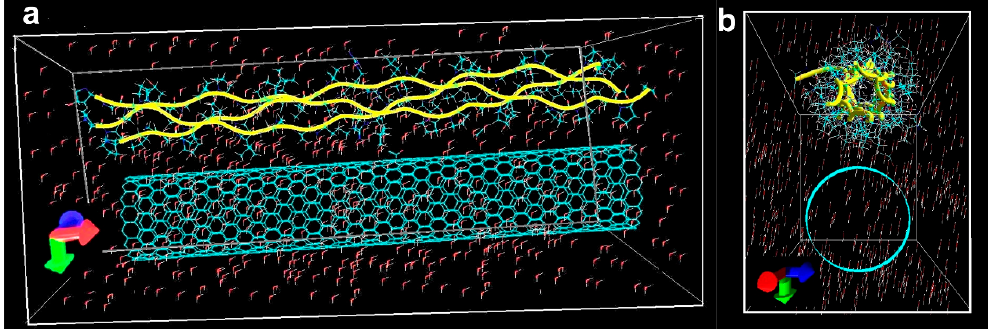
Figure 10. Atomistic model of the SWCNT (16,0)/collagen II (periodic water box) complex: ( a ) View of the model along the axis of the nanotube; ( b ) Cross-sectional view perpendicular to the axis of the nanotube (a triple-helix of collagen is highlighted in yellow). The arrows represent a tree-dimensional coordinate system (X – red arrow, Y – blue arrow, Z – green arrow).